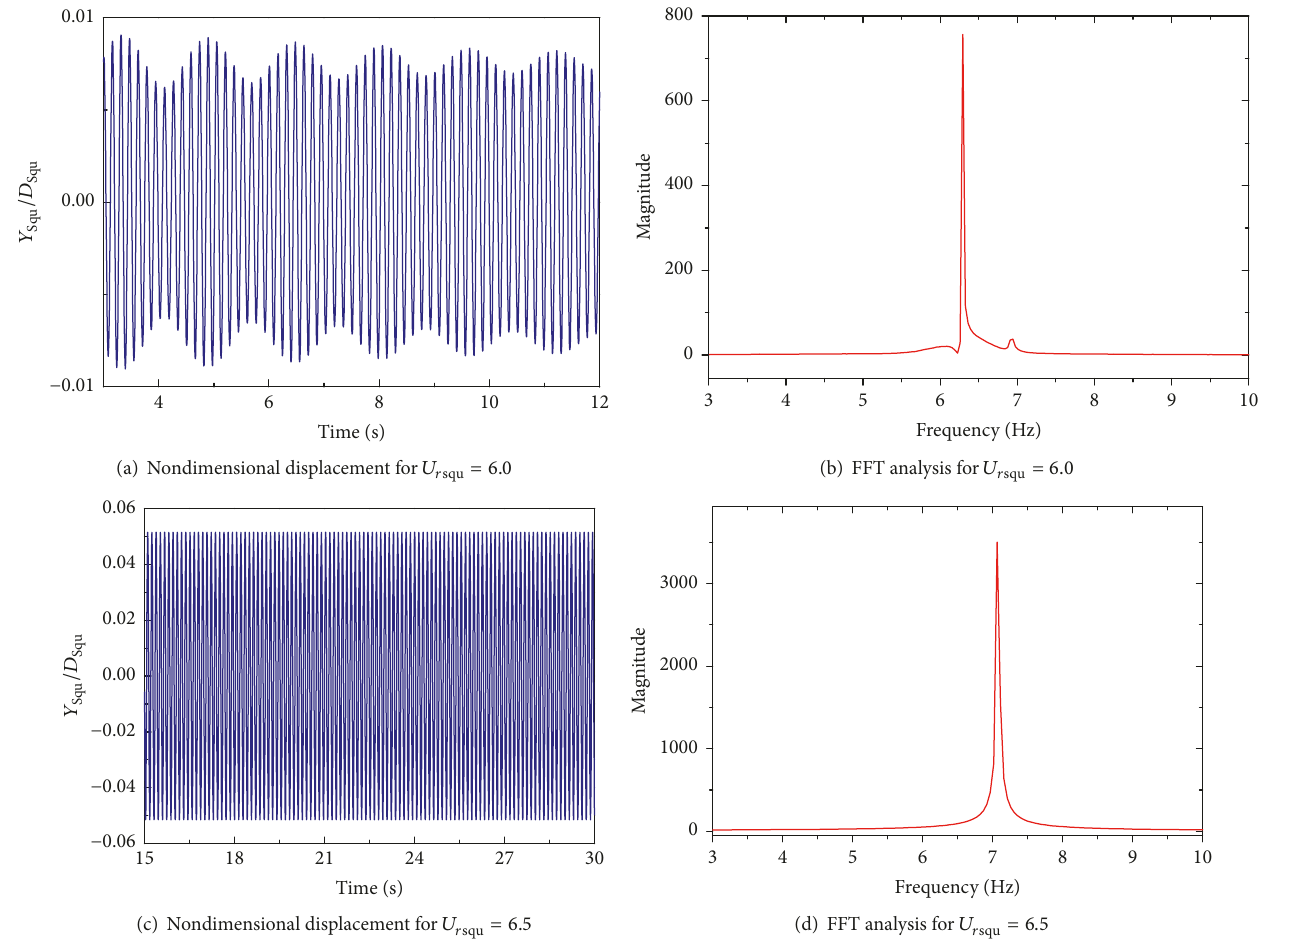
Figure 5: Displacement time-history and FFT analysis results for 𝛼 = 0 ∘